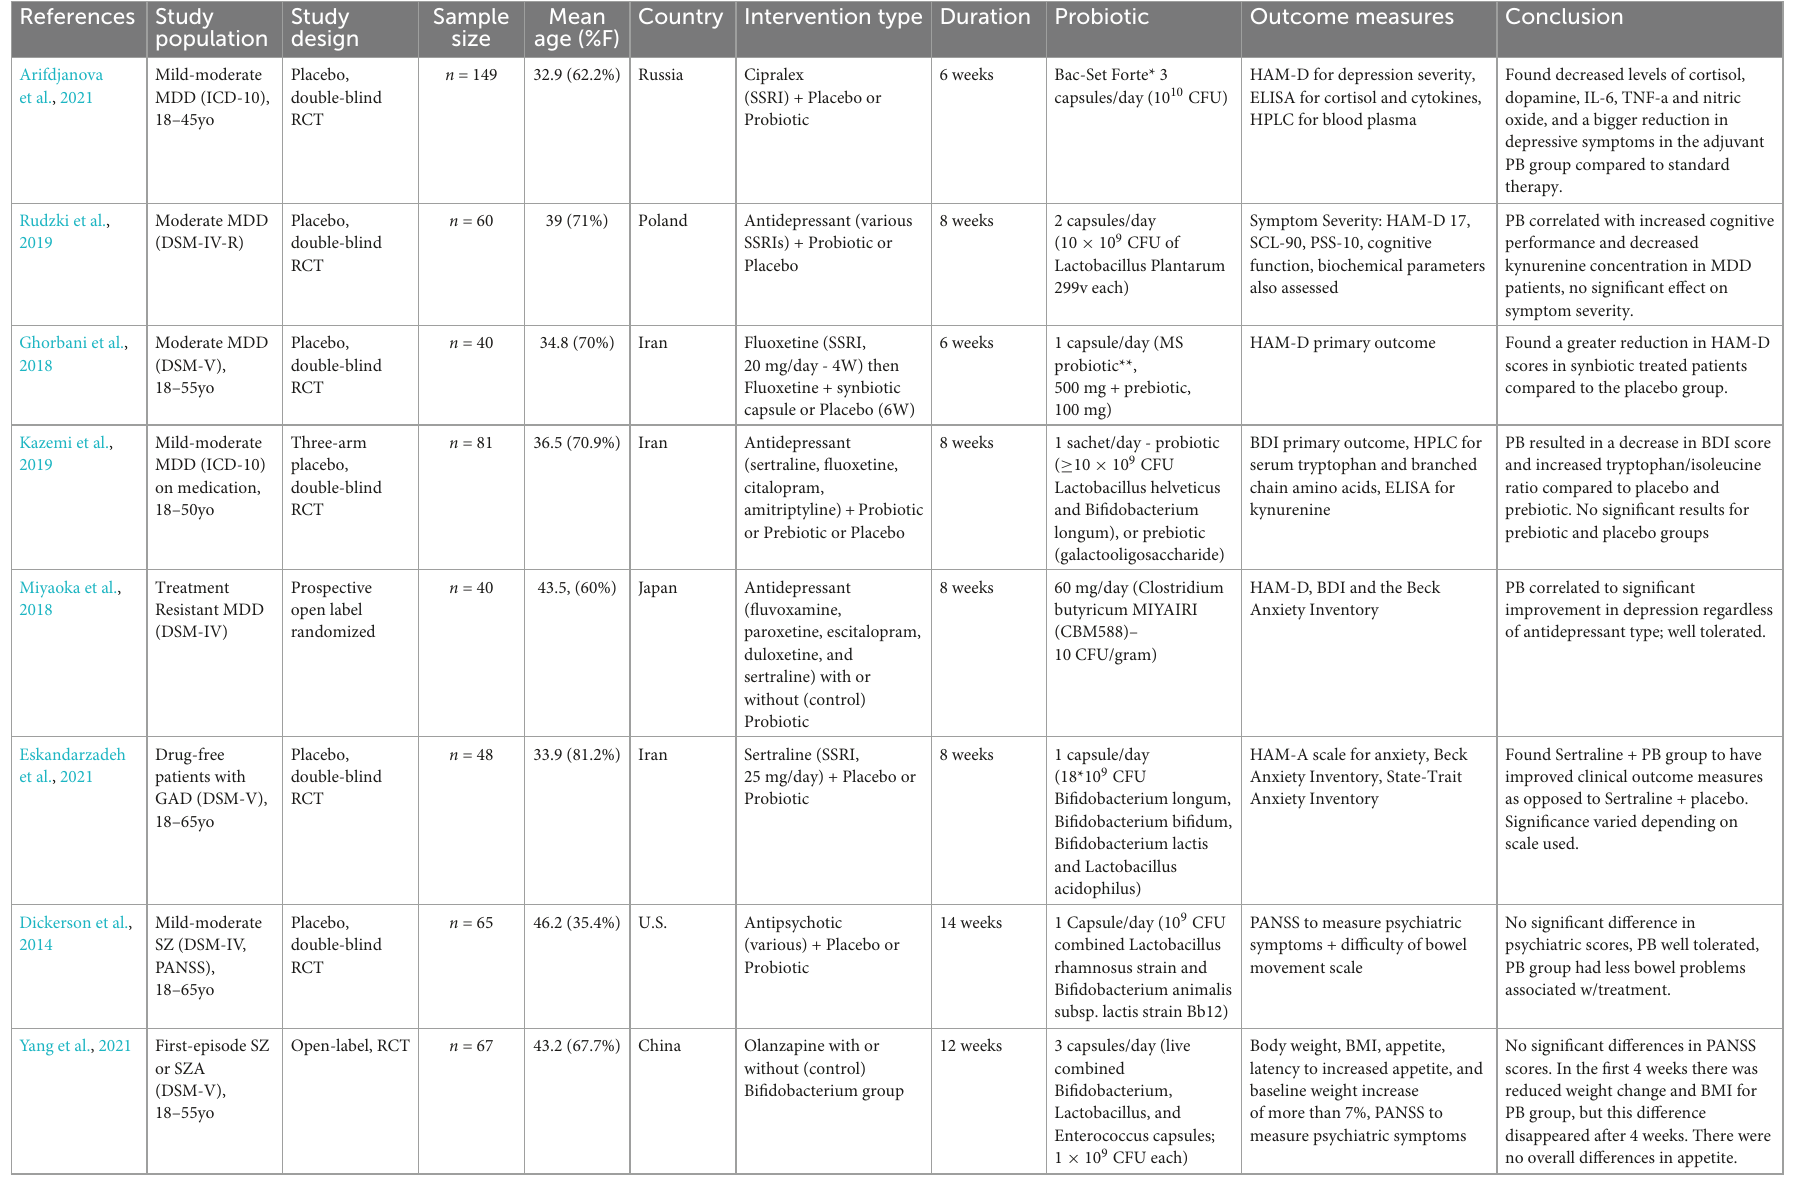
TABLE 2 Summary of key study characteristics and